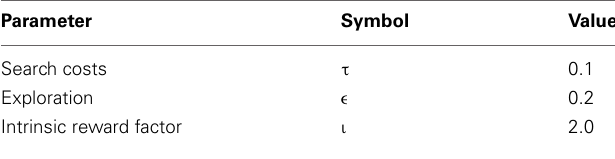
Table 1 | Default parameters that were used in the feeder